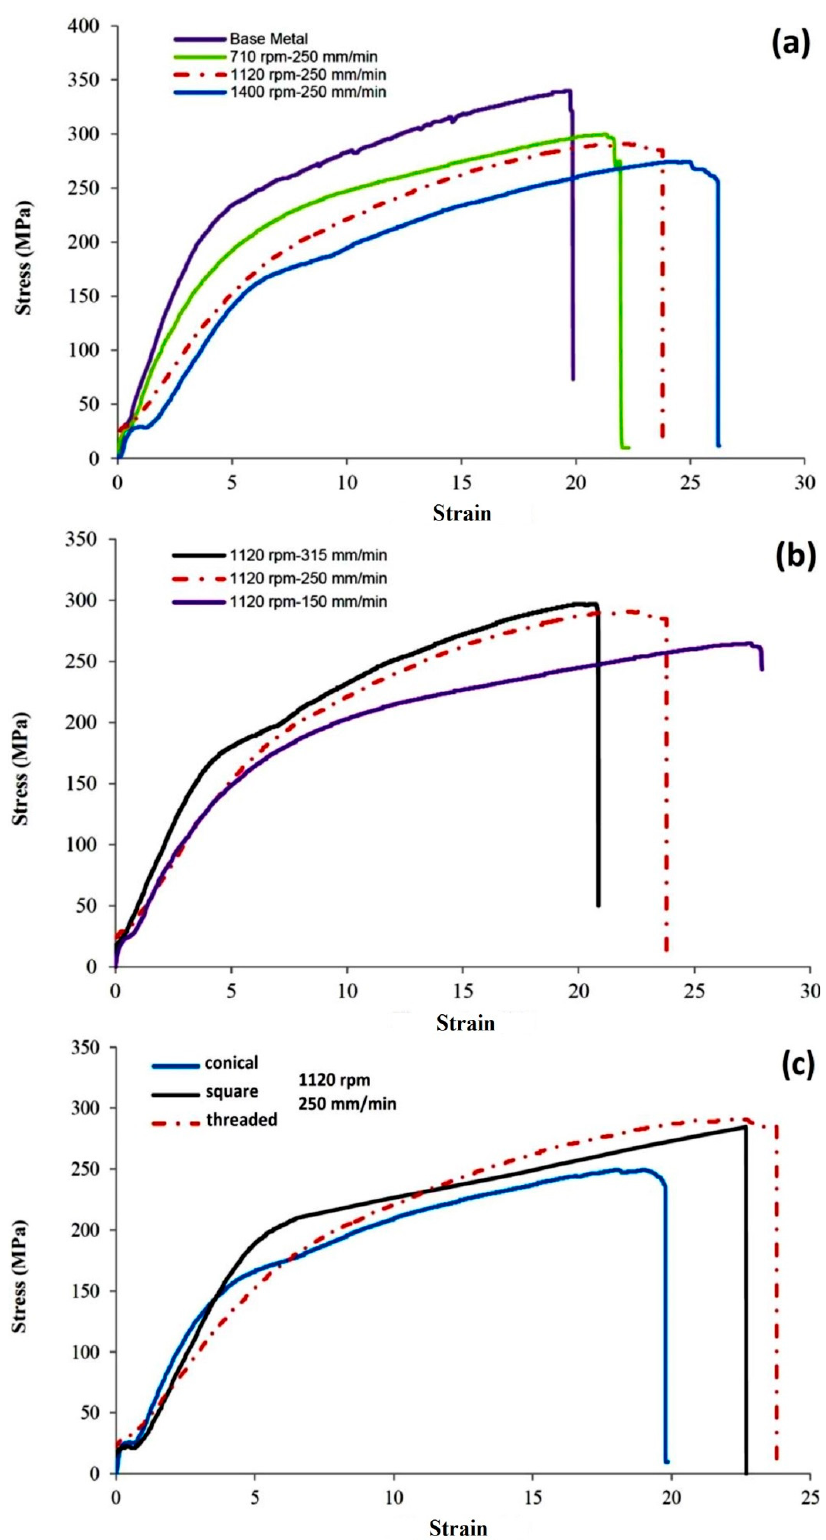
Figure 14. Tensile test results for the AA1100 aluminium welds; ( a ) RPM = 710, 1120 and 1400 at feed rate of 250 mm/min, ( b ) feed rate = 150, 250 and 315 mm/min at 1120 RPM and ( c ) comparison between conical, square and threaded pin tools, processed in constant welding speeds (1120 RPM and 250 mm/min).